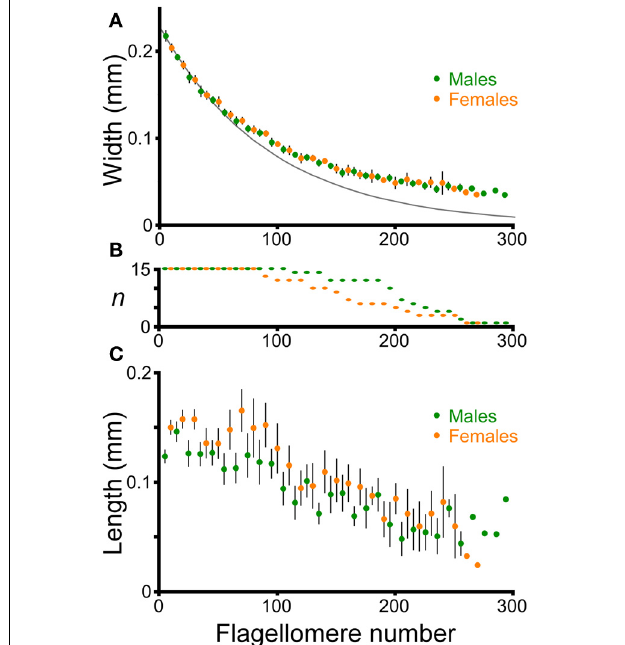
FIGURE 6 | Morphology of flagellomeres. Flagellomeres are numbered from proximal to distal along the flagellum. One antenna was used from each of 15 adult males and 15 adult females. (A) Width of individual flagellomeres (mean ± 2 s.e.m.). Only the data from every tenth flagellomere are graphed for clarity, and are staggered to facilitate comparison (males: 5th, 15th, 25th, etc. flagellomeres; females: 10th, 20th, 30th, etc.). The dark gray line is the simple exponential fit for the averages of the first 50 flagellomeres for both males and females: y = e ∧ ( − 0 . 010744 x − 1 . 46984), where y = width in mm, and x is flagellomere number ( r 2 = 0 . 97). (B) Sample size of flagellomeres used for each point (shorter antennae have fewer flagellomeres). (C) Length of individual flagellomeres (mean ± 2 s.e.m.). Only the data from every tenth flagellomere are graphed for clarity, and are staggered, as in (A)